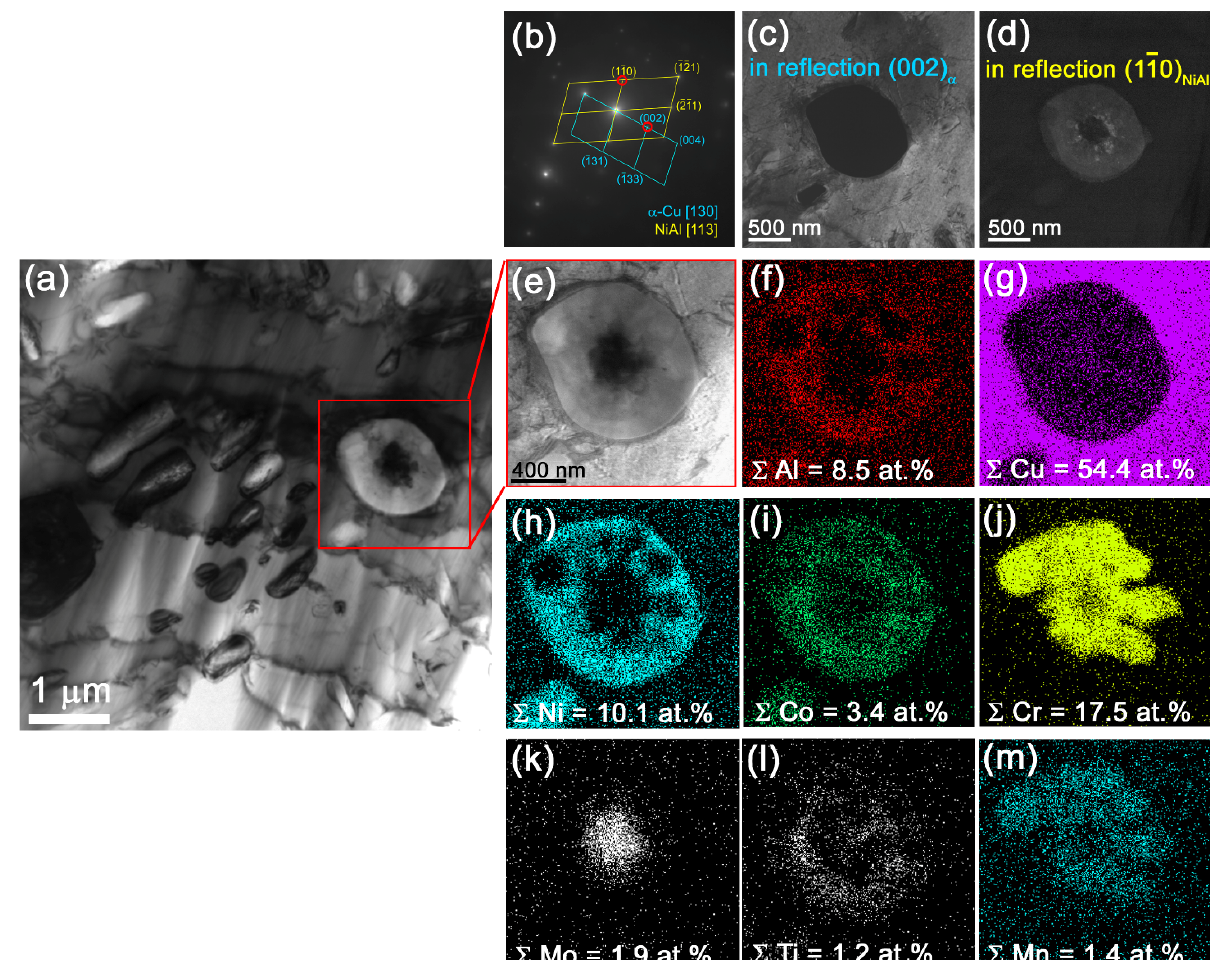
Figure 7. Bright-field TEM image of the 10% Ud composite ( a , e ), SAED pattern from a Cr-rich particle ( b ), dark-field images of the particle ( c , d ) in reflections (002) α -Cu and (110) NiAl , EDS element distribution maps ( f – m ).